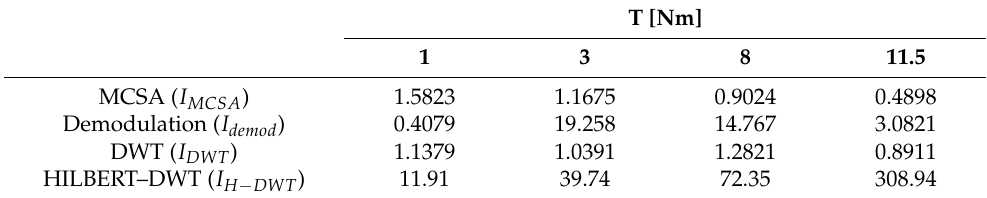
Table 3. Diagnostic indexes at constant speed—variations in requested torque.